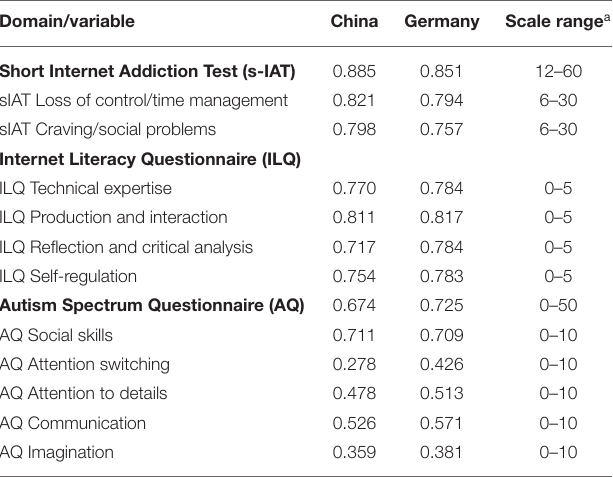
TABLE 1 | The reliabilities (Cronbach’s α ) of the short Internet Addiction Test (s-IAT), Internet Literacy Questionnaire (ILQ), and the Autism Spectrum Quotient (AQ) and their subscales in the Chinese and German